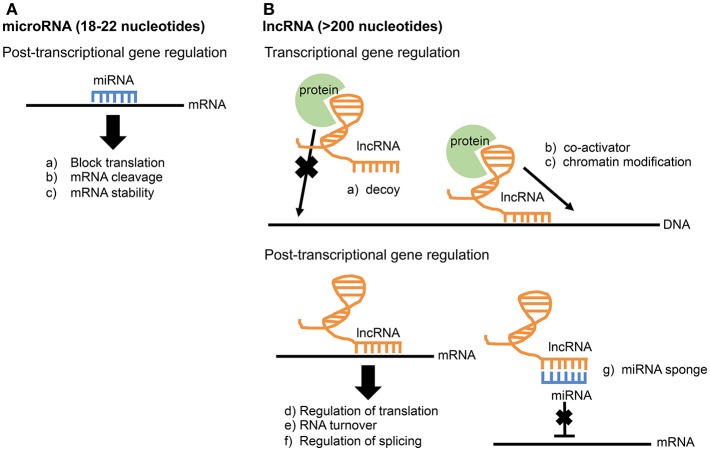
Comparison of miRNA and lncRNA function. (A) microRNAs function post-transcriptionally through direct base-pair interactions with mRNA. (B) Due to their larger size, lncRNAs have greater functional diversity and can interact with RNA, DNA, and protein. lncRNAs are known to influence gene expression at both the transcriptional and post-transcriptional level.